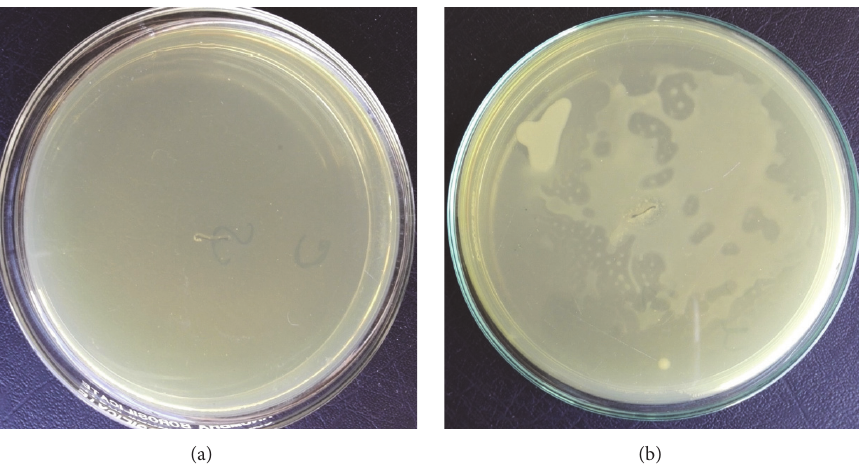
Figure 7: In vivo colonization of E. coli with coated and uncoated suture (a) shows the results of in vivo antibacterial activity with coated suture while (b) shows the in vivo antibacterial results with uncoated